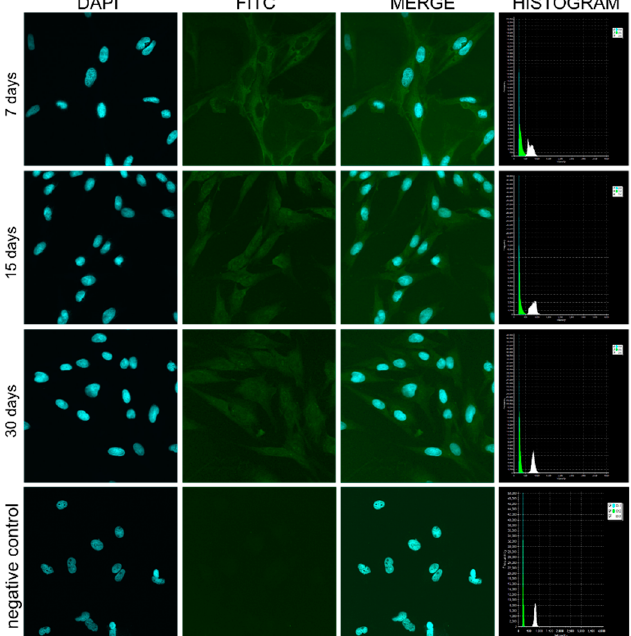
Figure 16. Confocal microscopic observation of cytokeratin 8 + 18 + 19 (pCK) levels and cellular distribution in keratinocytes in the designated periods of 7, 15, and 30 days of in vitro culture. pCK-labeled fibroblasts were used as a negative control. DAPI—4 ′ ,6-diamidino-2-phenylindole, FITC—fluorescein.